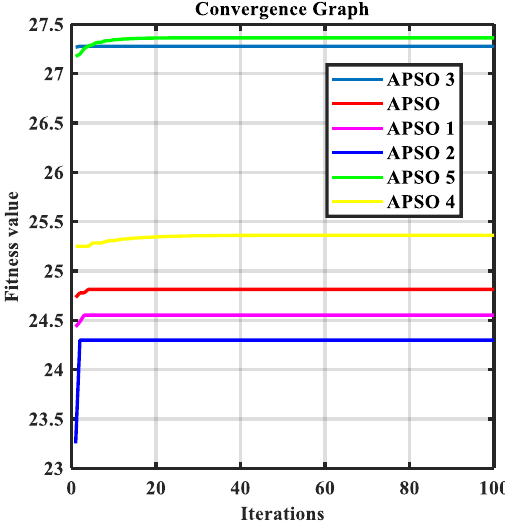
Figure 5. Results comparison between APSO and its variants for 100 PHEVs.